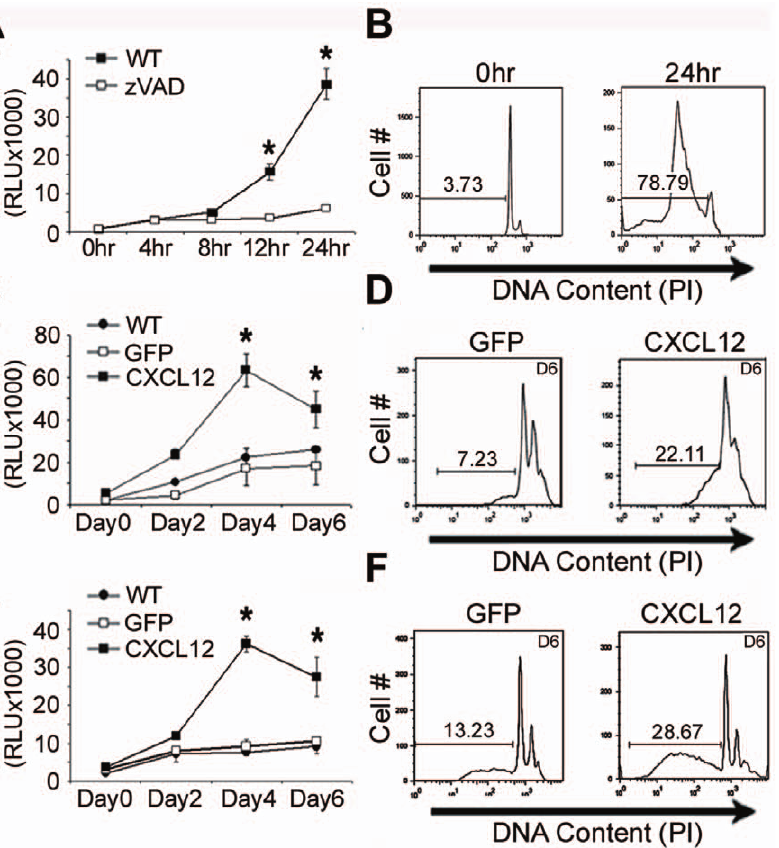
Figure 3. Re-establishment of CXCL12 expression enhances anchorage-independent cell death. (A, B) Non-transformed rat IEC6 intestinal epithelial cells were cultured as a suspension on poly-HEMA [10 mg/ml]-coated dishes. Caspase-3/7 activity (A) was measured using a luminescence-based assay. Execution of apoptosis was confirmed by propidium iodide staining (B) to display DNA degradation. Addition of zVAD [10 m g/ml], a pan-caspase inhibitor, blocked caspase-3/7 activity. Stable HCT116 (C, D) and HT29 (E, F) human colorectal carcinomas expressing CXCL12 or GFP (control) were plated on poly-HEMA. CXCL12 re-expression minimally altered baseline cell death at day-0 but markedly enhanced non-adherent cell death over time indicated by heightened caspase-3/7 activity and DNA degradation relative to GFP control cells. Values in panels (A–F) are mean 6 SD of three independent experiments completed in triplicate. * indicates statistically significant difference between GFP and CXCL12-expressing cells ( P #